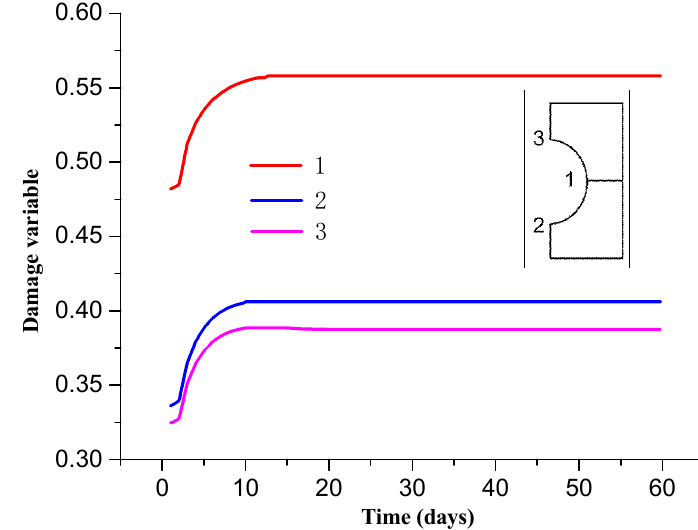
Figure 9. Distribution curve of surrounding rock damage over time.